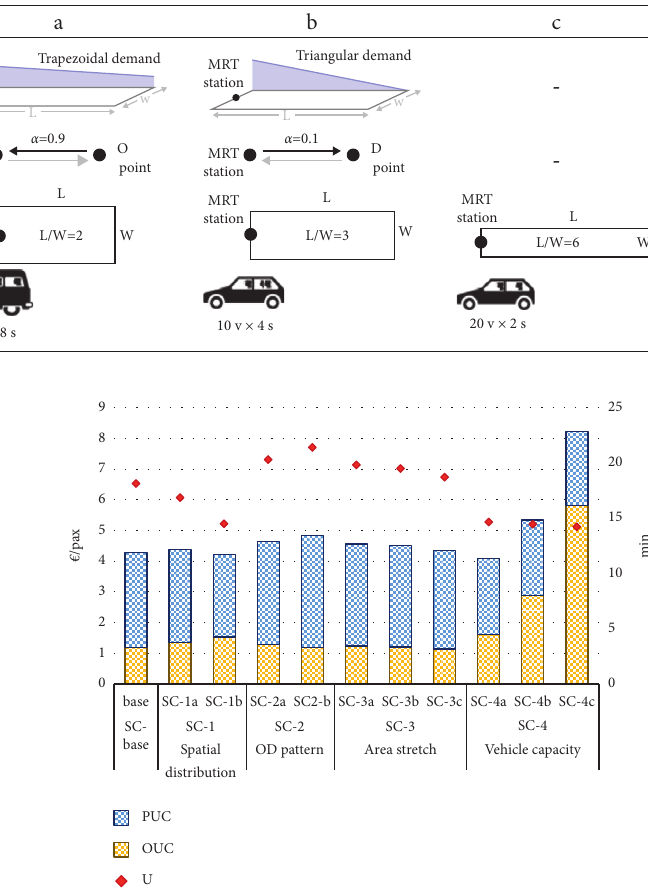
Figure 9: Results of the second set of simulations for the DRF (for result interpretation; PUC � passenger unit cost; OUC � operator unit cost; U �